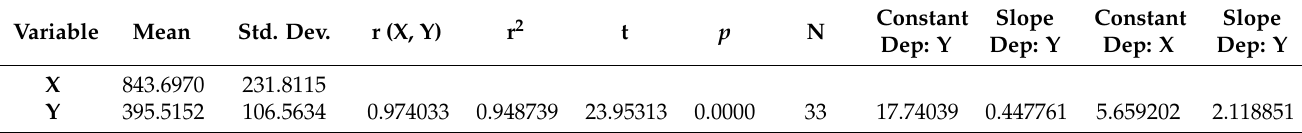
Table 5. Results of statistical analysis of correlation of variables for vehicle charging stations — AC and vehicle charging stations — DC.